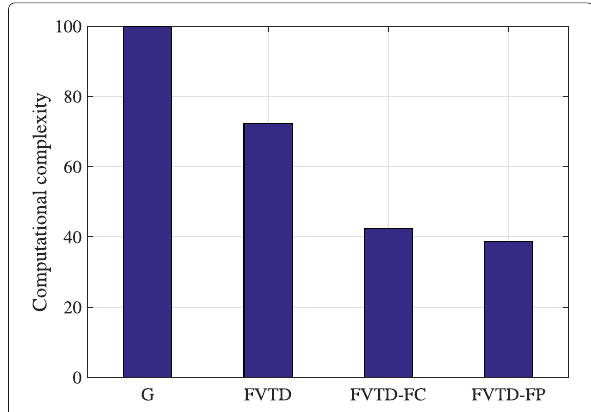
Fig. 11 Relative computational complexity of centralized algorithms presented in the paper. The scenario is composed of 5 BSs and 50